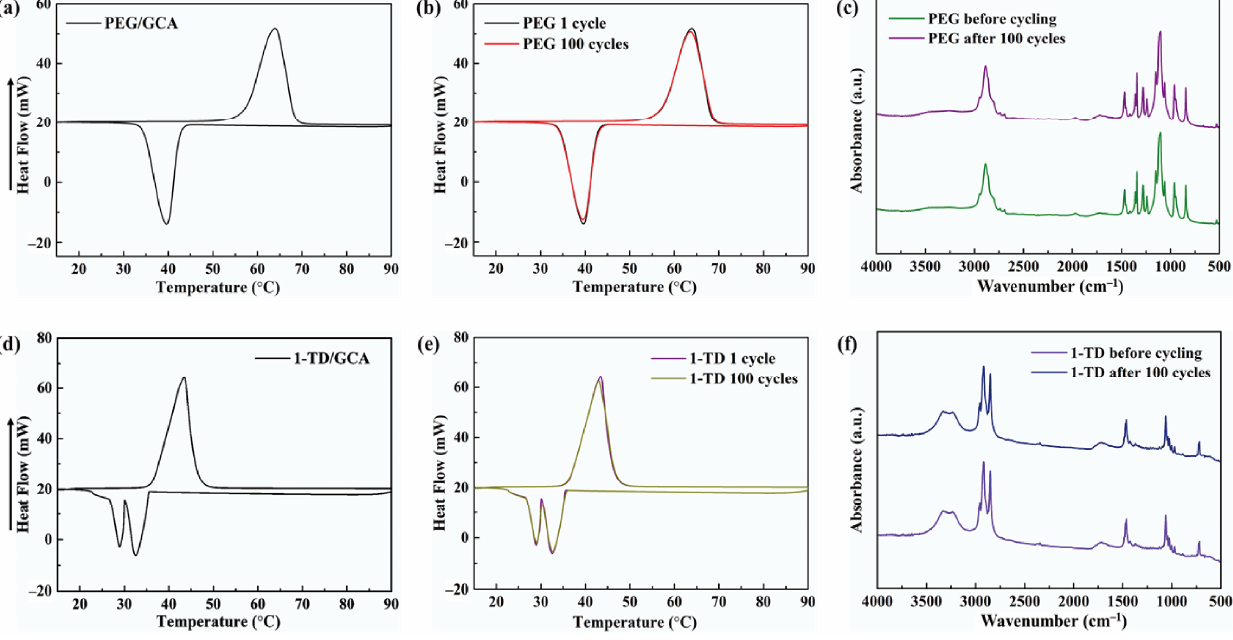
Figure 5. DSC curve of ( a ) the PEG/GCA composite and ( b ) DSC 100 cycling test. ( c ) FTIR peaks after 100 cycles. DSC curve of ( d ) 1-TD/GCA composite and ( e ) DSC 100 cycling test. ( f ) FTIR peaks after 100 cycles. Table 2. DSC results of the PEG/GCA and 1-TD/GCA composites.